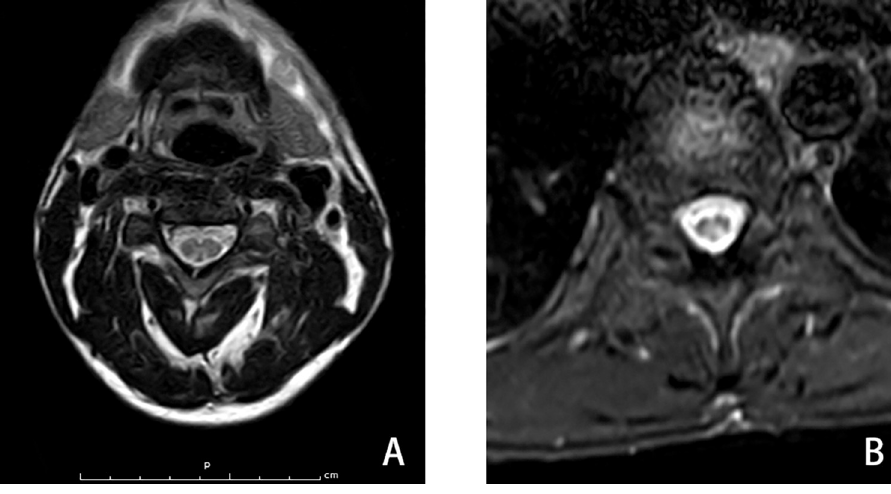
Fig 1. Spinal cord magnetic resonance imaging of case 18. Transverse sections of spinal cord showing “V” inverted T2 hyperintensity in the cervical spinal cord (A) and ellipse-shapes T2 hyperintensity in the thoracic spinal cord (B).